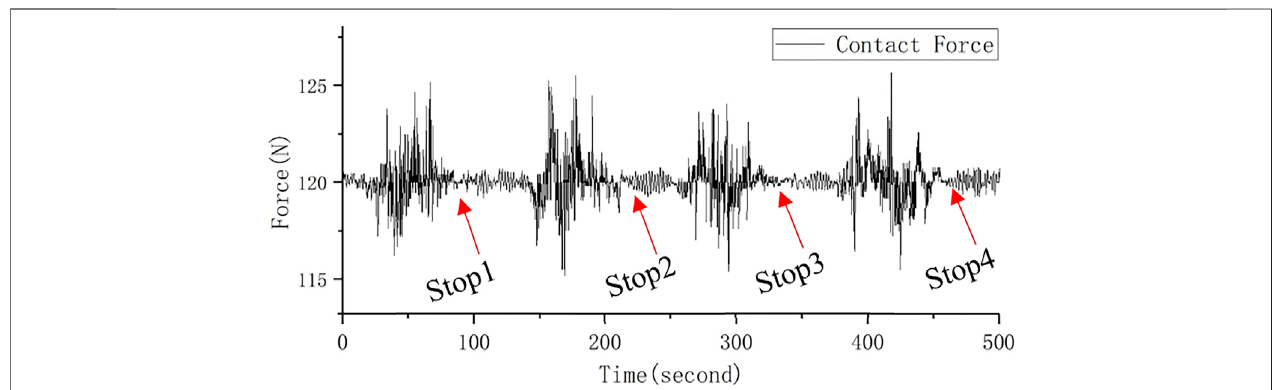
FIGURE 10 | In-line contact force